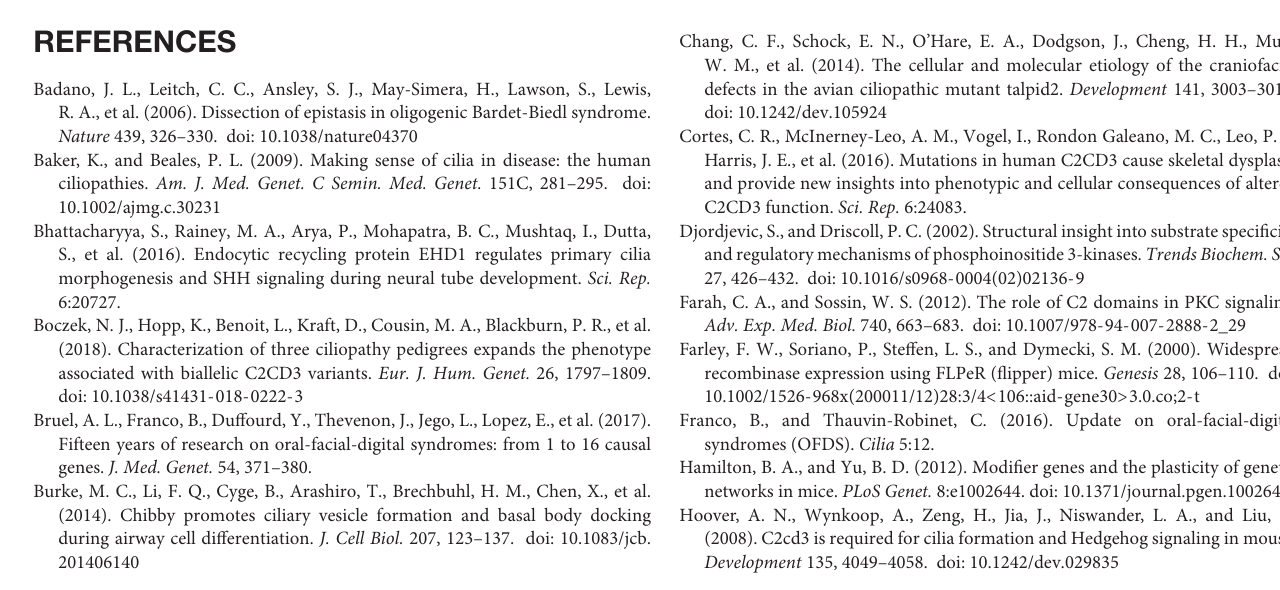
Supplementary Figure 1 | Reported splice variants in murine C2cd3. Seven protein-coding variants (NCBI accession number NM or XM) produce four protein isoforms (one non-coding mRNA is also predicted (XR_003946487.1, not shown)). Two isoforms contain C2CD3N-C2 domain (A,C) while two isoforms contain only PKC-C2 domains (B,D) . Supplementary Figure 2 | (A) Western blot of Gli3FL and Gli3R in CD1 and C57BL/6J backgrounds. (B) Densitometry of Gli3FL and Gli3R in each lane was measured by ImageJ. Gli3FL/Gli3R ratio is higher on C57BL/6J background ( n = 4, t -test, ∗ indicates P < 0.05). Supplementary Figure 3 | Exon expression in C2cd3 mutants. (A) RT-qPCR of exon 8-9 and 32-33 in wild-type ( n = 5), C2cd3 ex2 / + ( n = 6), and C2cd3 ex2 / ex2 ( n = 4) embryos shows significantly reduced, but detectable levels of C2cd3 downstream of exon 2 ( t -test, ∗ indicates P < 0.05; ∗∗ indicates P < 0.01; NS: not significant). Supplementary Figure 4 | MicroCT analysis of E17.5 mouse embryos. Snapshots of microCT 3D images of (A,A (cid:48) ) wild type and (B,B (cid:48) ) C2cd3 ex9fl / fl ;Wnt1Cr e mutant embryos. The frontal bones (A,B) and mandibular bones (A (cid:48) ,B (cid:48) ) are marked by blue. The bone volume of (C) frontal bones and mandibular bones (D) was measured by Inveon Workstation Software (Siemens Medical Inc), the results indicates that there is no significant difference between wild type and mutant ( n = 4 for wild type or mutant, t -test, NS: not